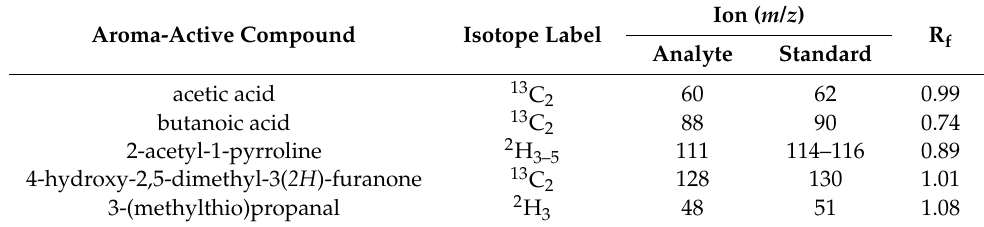
Table 2. Selected ions ( m / z ) of analytes and stable isotopically labeled internal standards as well as response factors (Rf) used in stable isotope dilution assays for quantitation of five selected odorants in non-fermented LPI and fermented LPI with S. xylosus (DSM 20266) and L. sakei ssp. carnosus (DSM